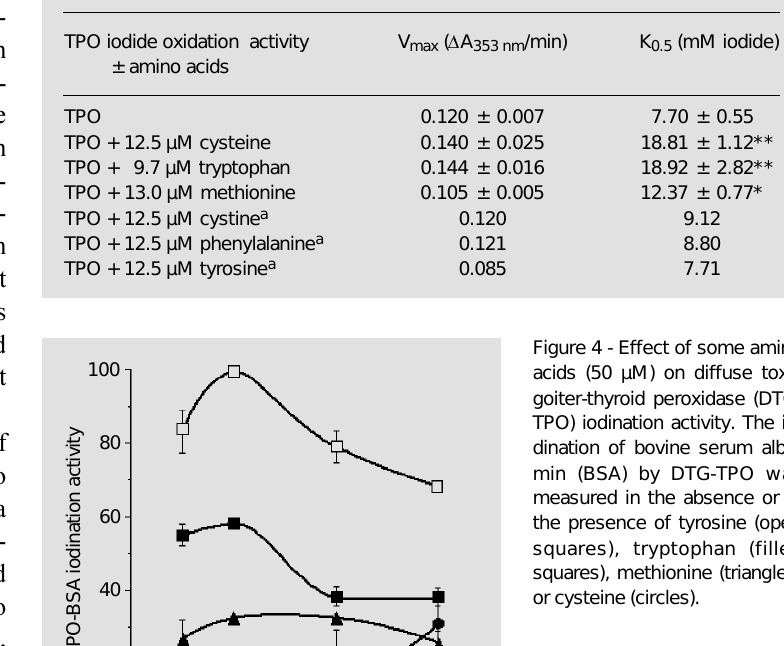
Table 1 - Kinetic parameters of thyroid peroxidase (TPO) iodide oxidation in the presence of some amino acids. Results are reported as mean ± SEM. a n = 1. *P<0.05; **P<0.001 vs TPO (paired Student t -test).